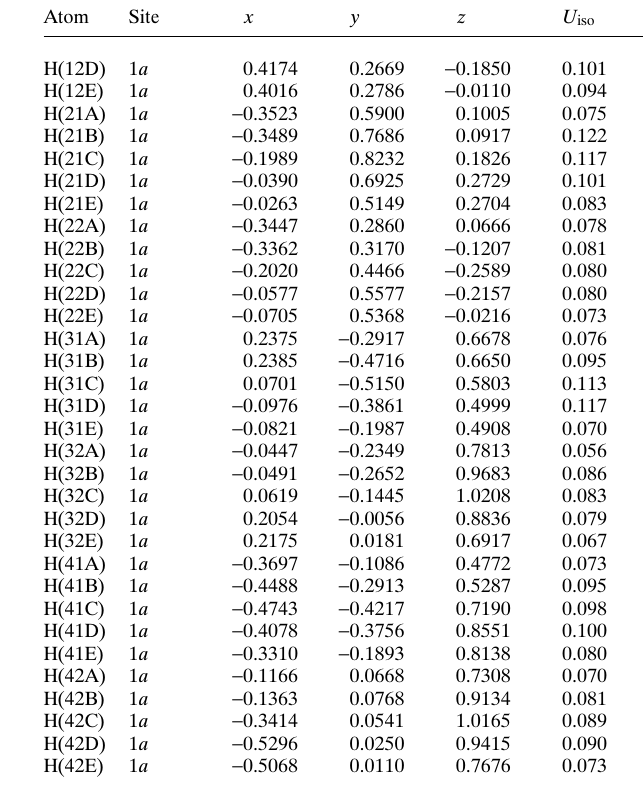
Table 2. Atomic coordinates and displacement parameters (in Å 2 )